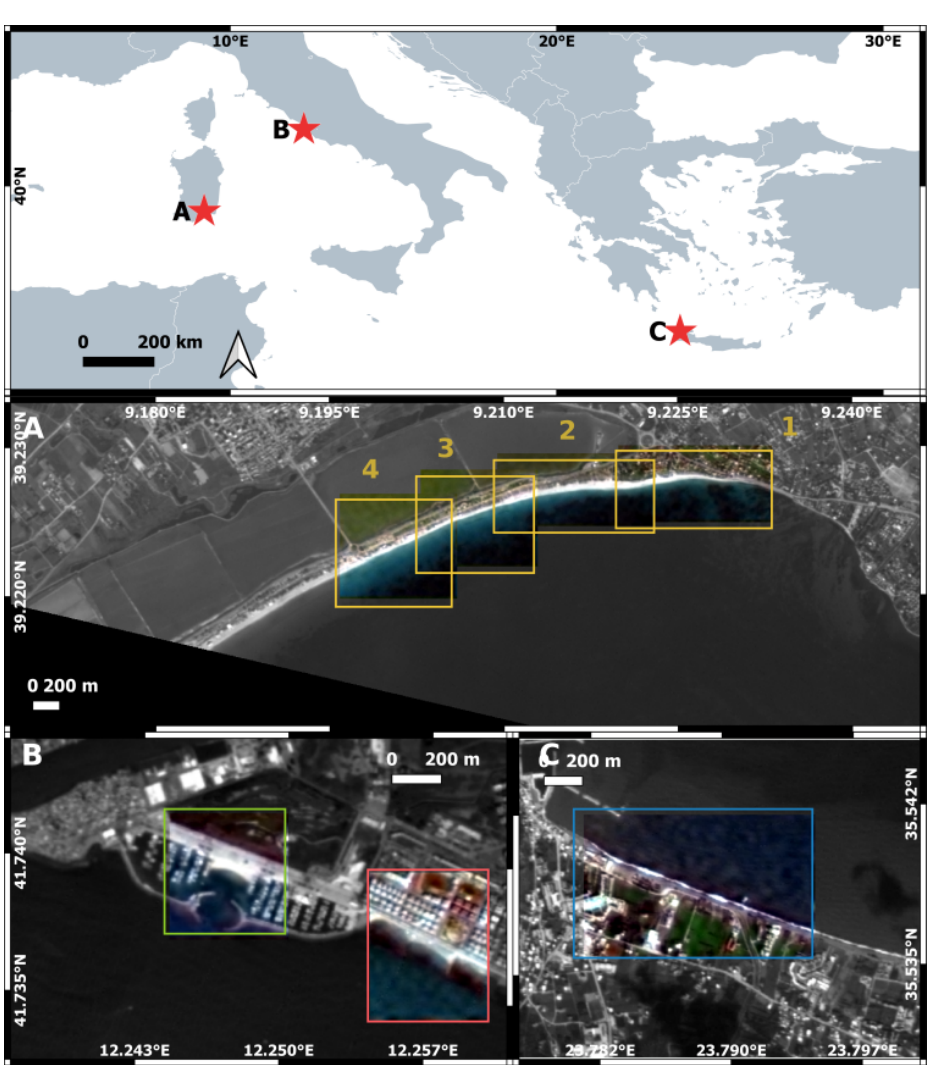
Figure 4. Location of test sites (top panel): ( A ) Poetto, Sardinia (Italy); ( B ) Ostia Port and Lido beaches, Lazio (Italy); ( C ) Kolymvari, Chania (Greece). Selected beaches are shown using PAN PRISMA images (panels A, B, C). Beach domains (AoI) used for algorithm testing are indicated by squares with different